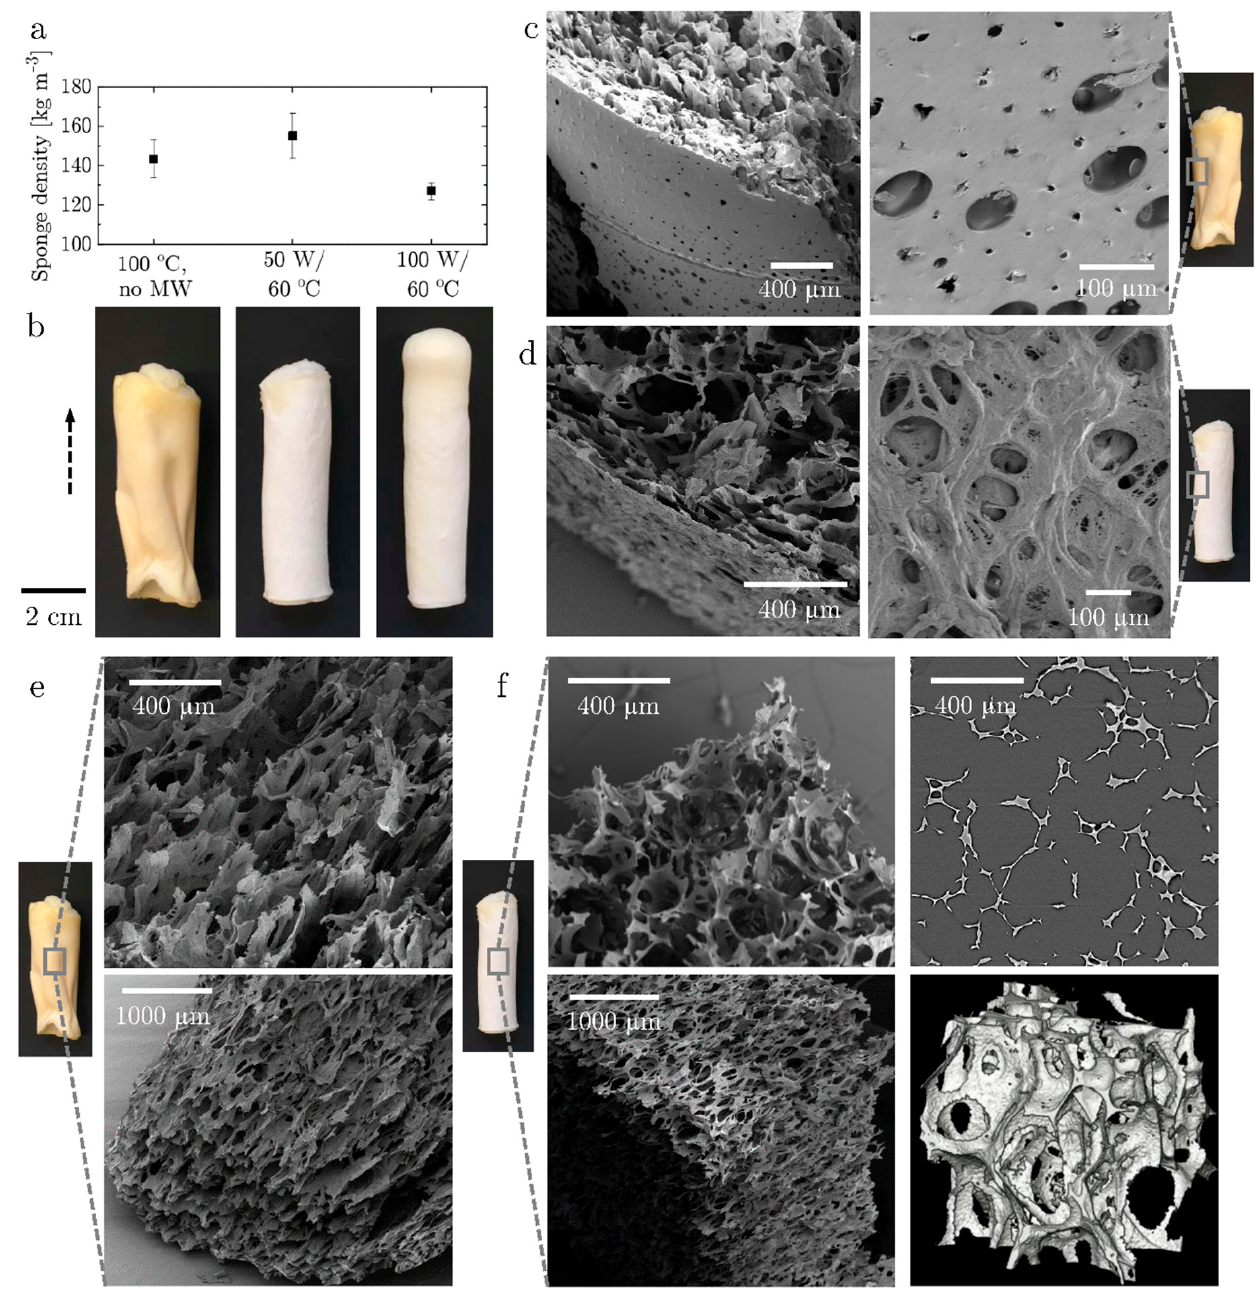
Figure 2. Macro- and microstructure of the protein sponge dried with and without superposition of microwave heating: ( a ) average densities of dried protein sponges at different drying conditions; ( b ) macroscopic images of dried protein sponges at different drying conditions (the dashed arrow indicates the expansion direction); ( c ) surface layer formed after drying at 100 °C without microwave heating; ( d ) surface layer of protein sponge dried at 50 W/60 °C; ( e ) inner structure formed after drying at 100 °C without microwave heating; ( f ) inner structure of protein sponge dried at 50 W/60 °C investigated by SEM (left) and μ -CT (right). The corresponding SEM images of the protein sponge dried at 100 W/60 °C are found in the Supporting Information Figure A (Supplementary Materials).